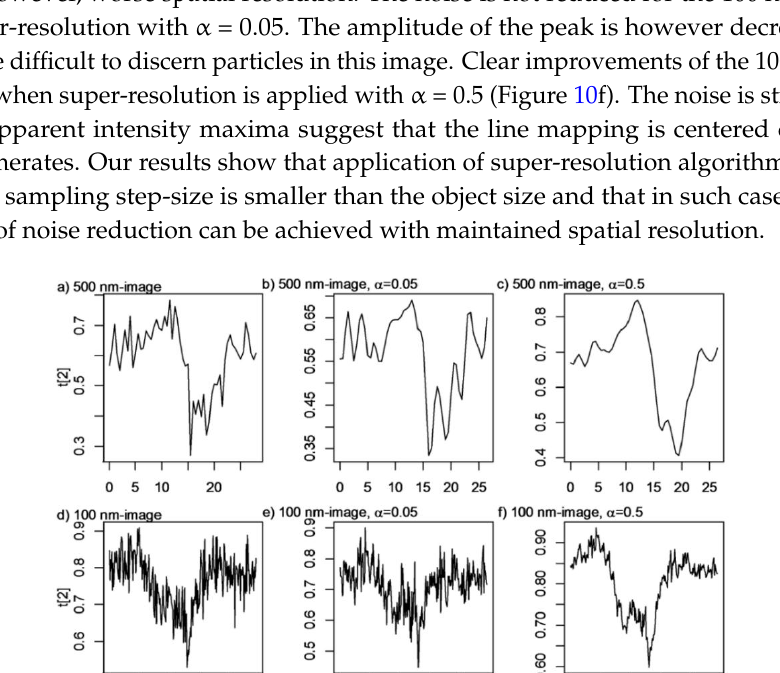
Figure 10. Intensity profiles for lines at X = 16.5 µm from the PC2 score (t[2]) map from the ( a ) 500 nm image; ( b ) super-resolution 500 nm image, α = 0.05; and ( c ) super-resolution 500 nm image, α = 0.5 Intensity profiles at X = 11.5 µm from the PC2 score (t[2]) map of the ( d ) 100 nm image; ( e ) super-resolution 100 nm image, α = 0.05; and ( f ) super-resolution 100 nm image, α = 0.5.